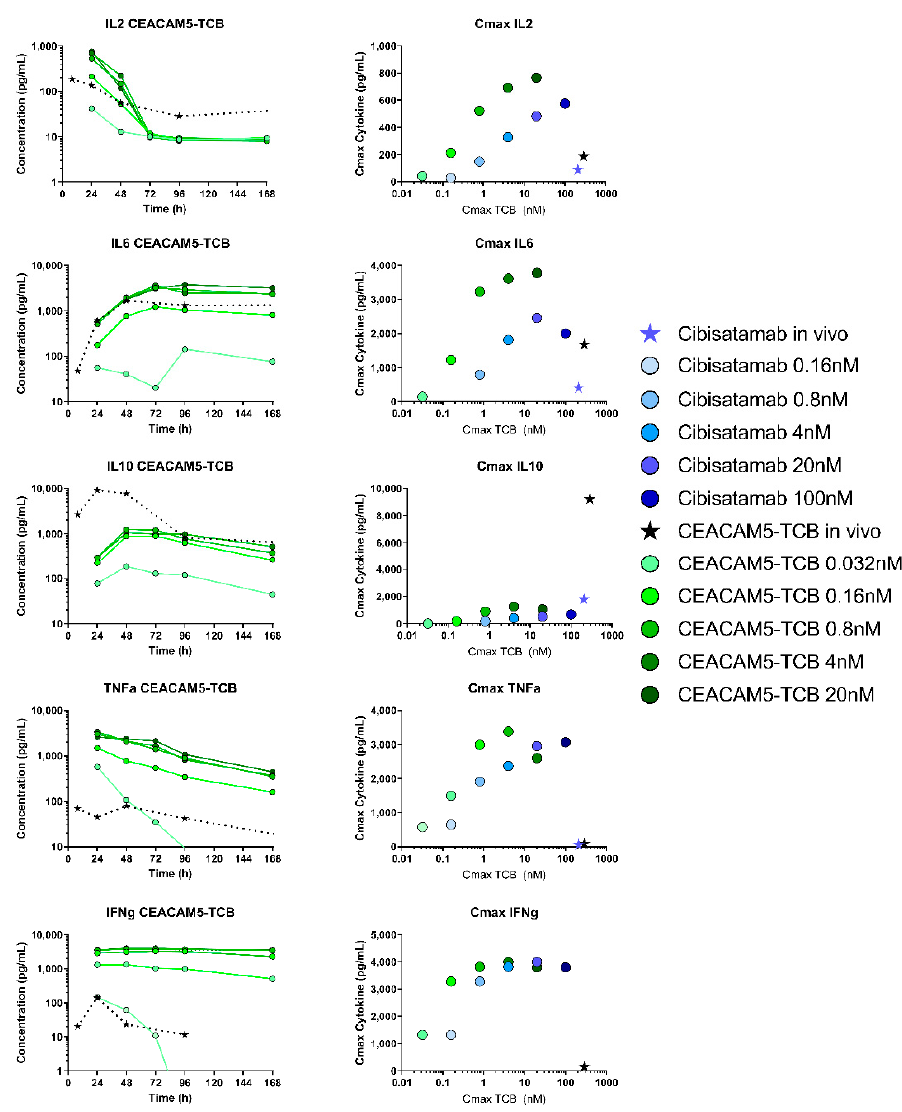
Figure 7. Comparison of cytokine release under TCB treatment in vitro and in vivo: Cytokine concentration profiles during the first 7 days after TCB injection, which corresponds to the maximal duration measured in vitro (data only shown representatively for CEACAM5-TCB) exhibit similar kinetics in vitro (green) as compared to in vivo (dose of 2.5 mg/kg) (black) (left panel). Further comparison of the correlation of Cmax of the drug and the observed Cmax of the cytokines in vitro and in vivo under cibisatamab (blue) and CEACAM5-TCB (green) treatment. For visual clarity, the data are shown as mean without SD and only the higher range of tested in vitro concentrations are depicted in comparison to the high in vivo Cmax.